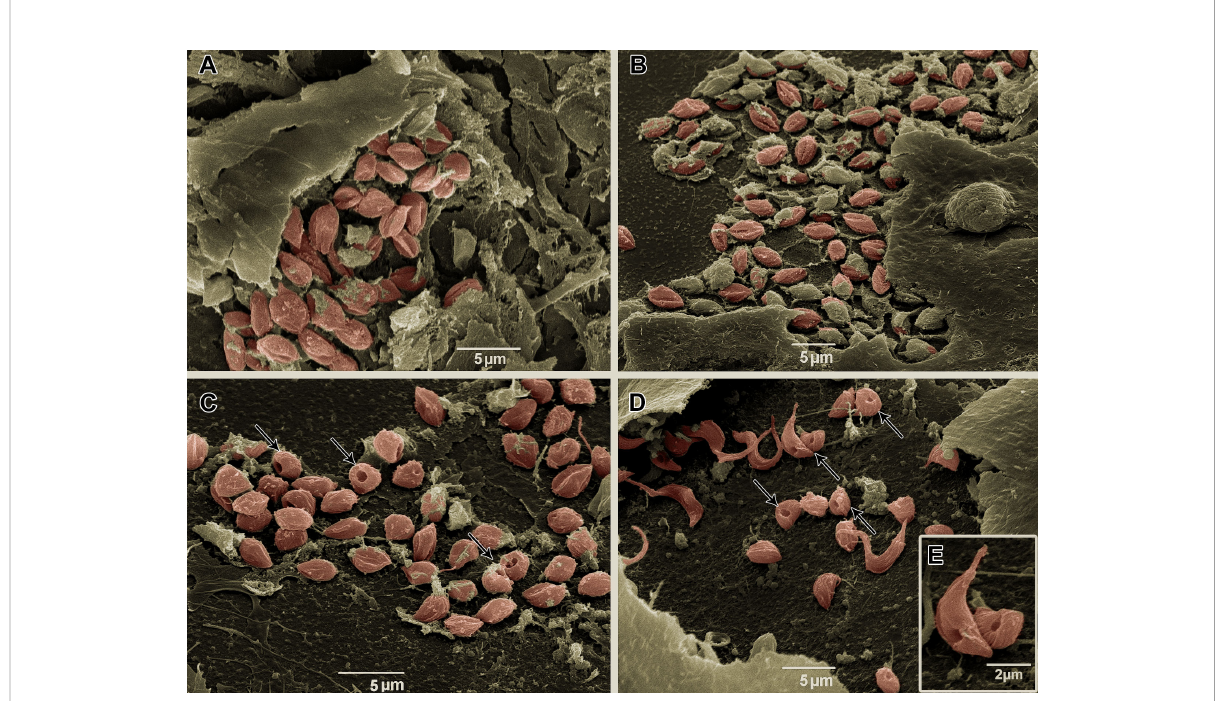
FIGURE 8 Scanning electron microscopy of T. cruzi intracellular forms treated for 72 h with Bz, AMD or their combination, showing the predominance of the phenotype generated by AMD in the combination Bz + AMD. (A) Untreated; (B) Bz MT (IC 50 /72 h = 5.4 m M); AMD MT (IC 50 /72 h = 2.5 m M) and (D, E) Bz:AMD Comb (Bz: IC 50 /72 h = 1.3 m M; AMD: IC 50 /72 h = 2.5 m M). Parasites were digitally colored in red. Black thin arrows indicate dilatation of the fl agellar